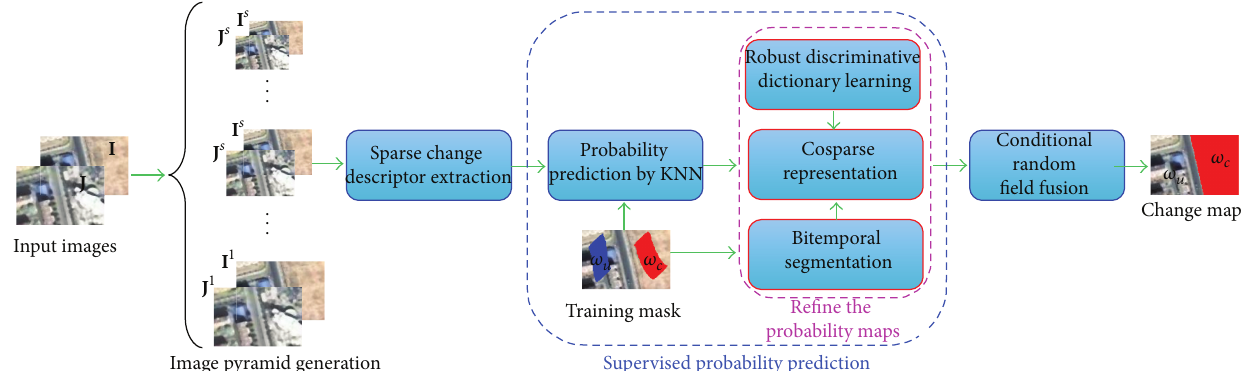
Figure 1: The flowchart of the proposed